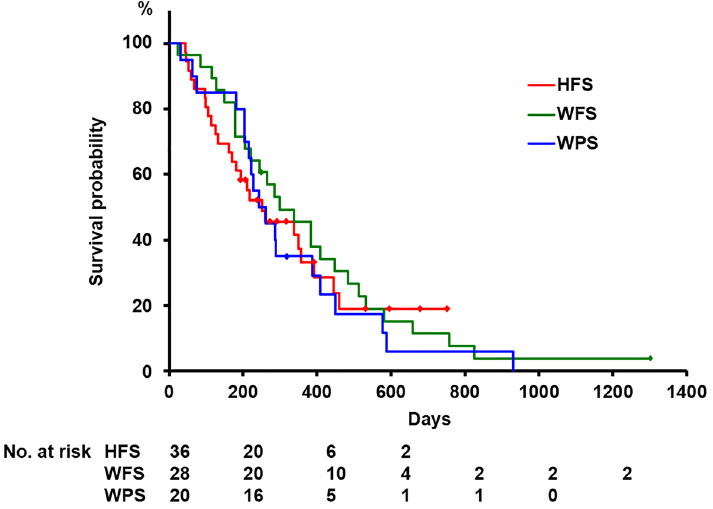
Figure 2. Kaplan–Meier plots for the estimation of the overall survival. There was no significant difference between the three groups in median survival time (251, 243 and 298 days in the HFS, WPS and WFS group, respectively, p = 0.785). HFS HILZO fully covered stent, WPS WALLFLEX biliary RX partially covered stent, WFS WALLFLEX biliary RX fully covered stent.